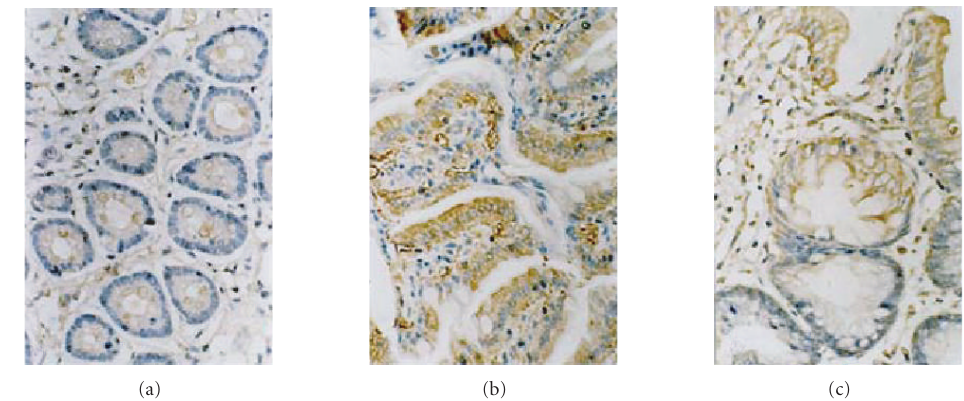
400), (b) expression of (cid:2) 400). (cid:2)